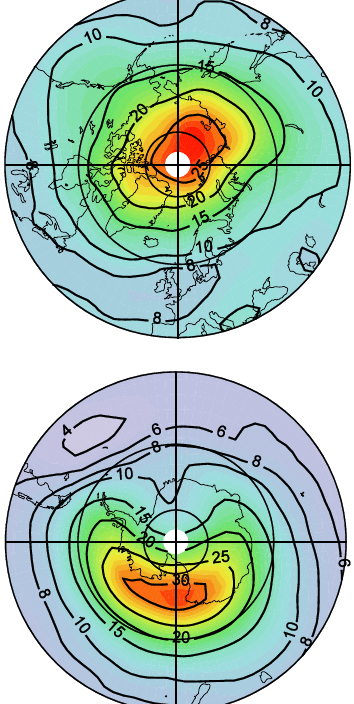
Fig. 9. Difference of the surface temperature between scenario and reference simulations averaged over the time period 2090–2100 (an- nual mean in K). Hatching represent the areas where the statistical significance exceed 95%